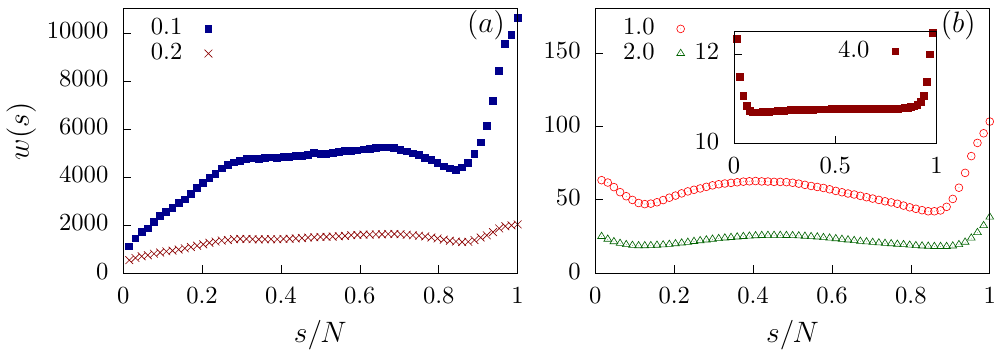
Figure 3. ( a ) Waiting time distribution w ( s ) of a flexible polymer through a flat channel ( α = 0 ◦ ) as a function of scaled translocation coordinate s / N , for weak forces f 0 = 0.1, 0.2 . ( b ) Waiting time distribution for strong forces : f 0 = 1.0, 2.0 . (Inset) w ( s ) for force values, f 0 = 4.0